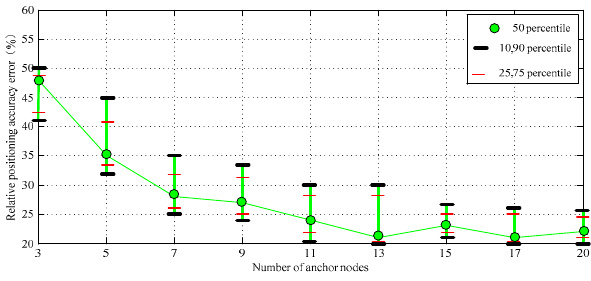
Figure 8. The confidence interval of the data I.